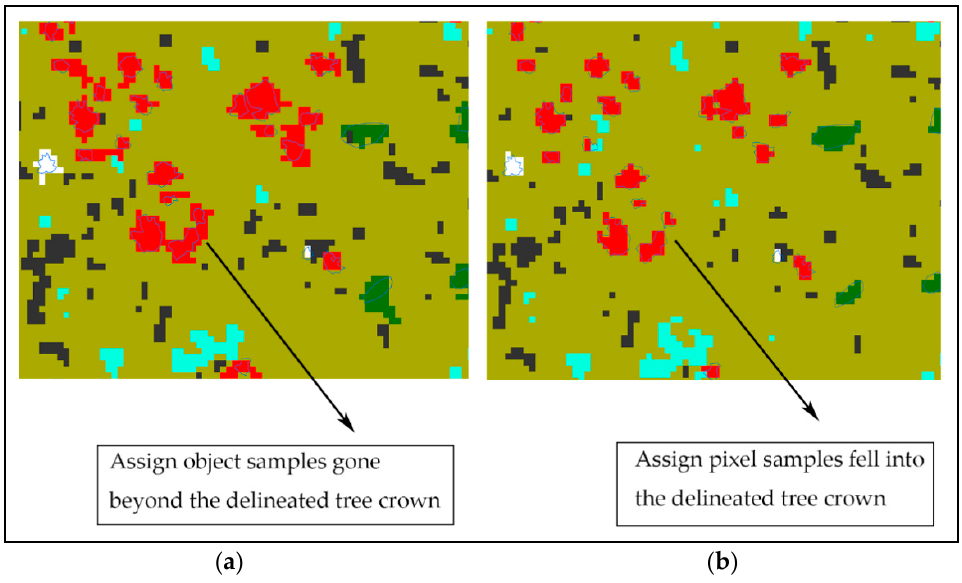
Figure 7. Subset of selected samples from GF2 1 m resolution images: ( a ) based on the object method; ( b ) based on the pixel method. bluepolygons correspond to delineated trees from UAV images, dark green corresponds to green trees, purple to red trees, white to gray trees, olive green to tree canopy areas, cyan to herbaceous, and black to shadow.